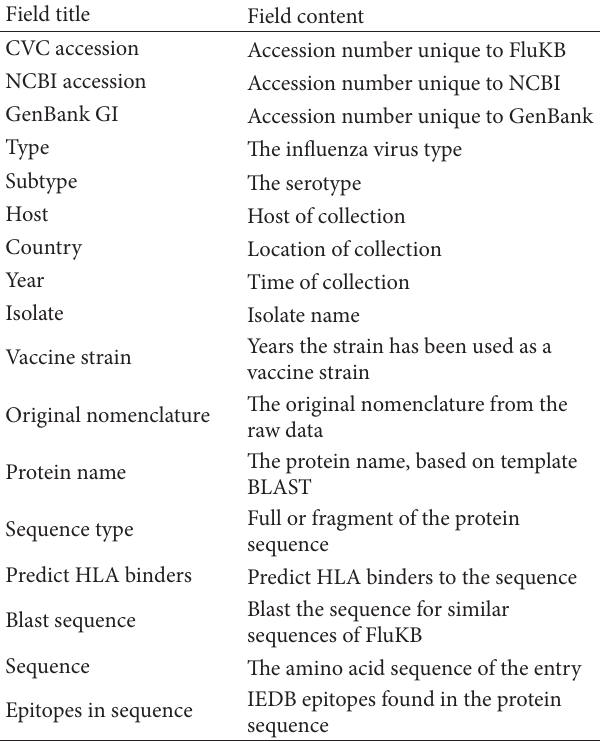
Table 2: The data fields in each protein entry. Table 3: The types of errors found for the geographical location in the metadata of the